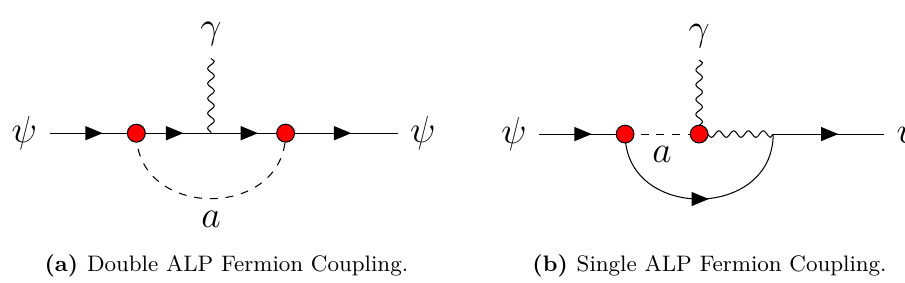
[44] and ∆ a . The effects appear at one- e µ